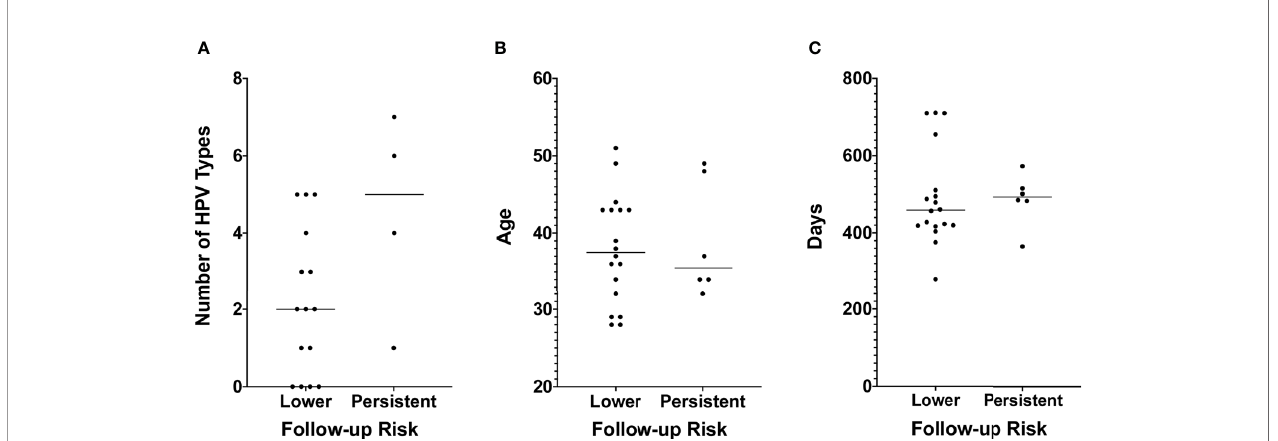
FIGURE 4 | (A) The number of HPV types for which a sample tested positive using the Roche Linear Array. Only 19 of the 24 samples used for TCRB sequencing and for which we obtained follow-up cytology and hrHPV test results had suf fi cient DNA to also conduct HPV typing. The number of HPV types for which a sample tested positive is shown on the y-axis, and risk as assessed by the follow-up cytology and hrHPV results is shown on the x-axis. A test for difference in the median value between the two groups was conducted using a Mann-Whitney test. p values are reported when p ≤ 0.05. (B) Age is shown on the y-axis. Other details are as in Panel (A) . (C) The number of days between the fi rst and second cytology and hrHPV test results is shown on the y-axis. Other details are as in Panel (A)